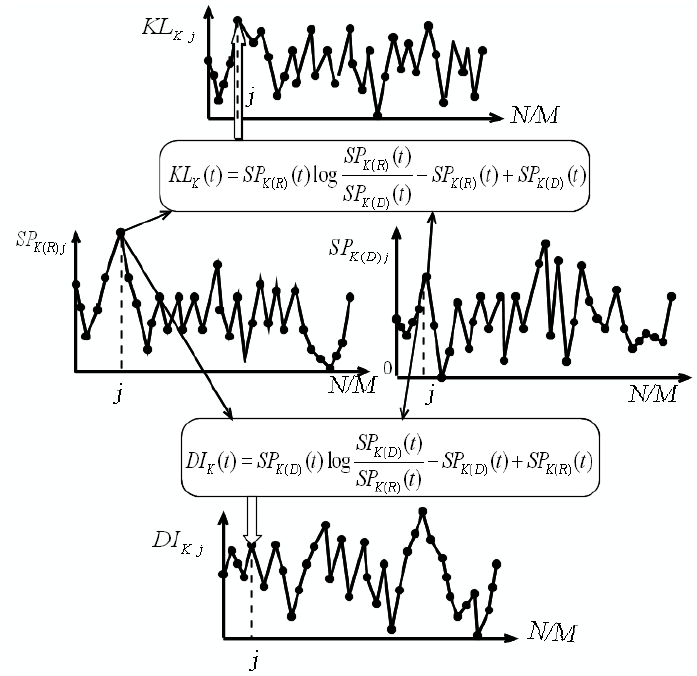
Figure 4. Derivation of the information